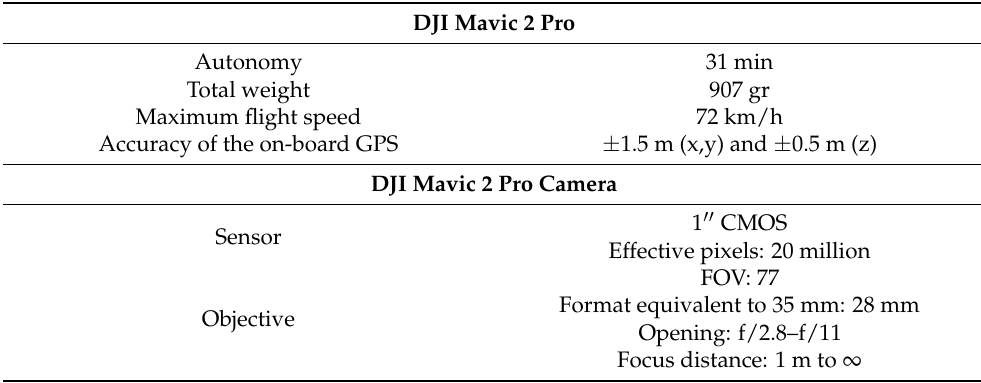
Table 2. UAV sensor’s specifications.